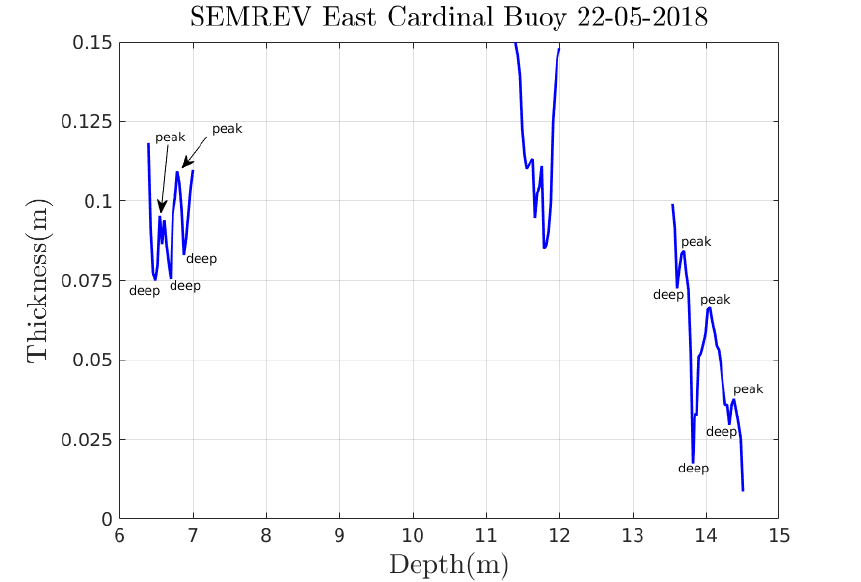
Figure A4. Three sub-trajectories on the mooring line of the East cardinal buoy in May